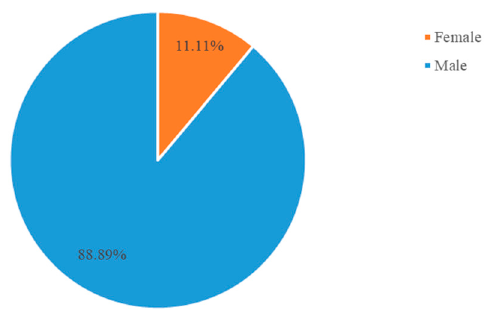
Figure 1. Gender of the CICT of the HCMs in Spain.